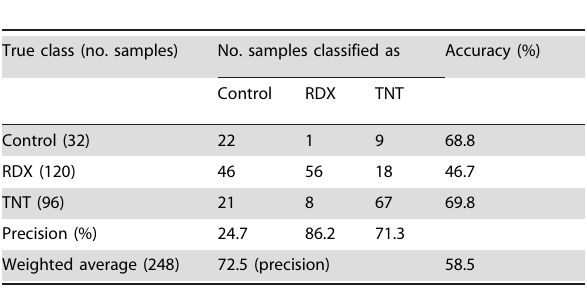
Table 3. Confusion matrix showing classification results obtained by clustering a .